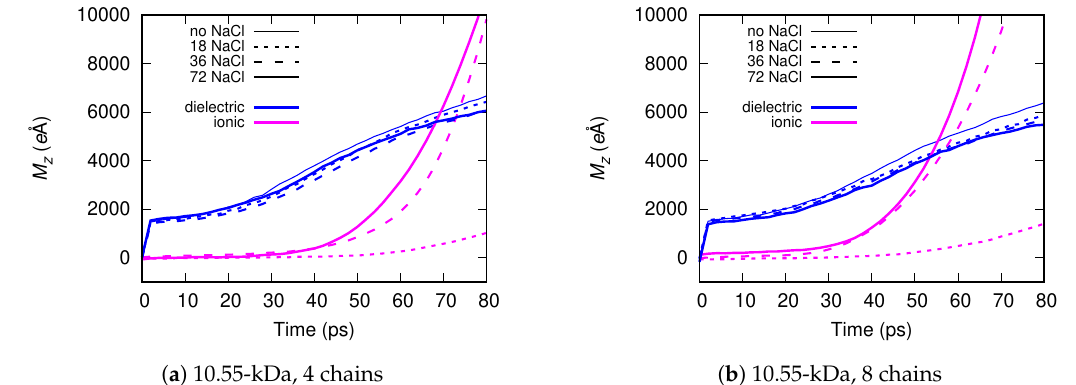
Figure 21. The z -component, M z , of dipole moments generated by molecules (blue) and ions (magenta) for different numbers of NaCl ion pairs (distinguished by dashing patterns, see the legend) under 1.5 V/nm. Systems with ( a ) four or ( b ) eight 10.55-kDa PEG chains were used. Plotted with gnuplot [56].